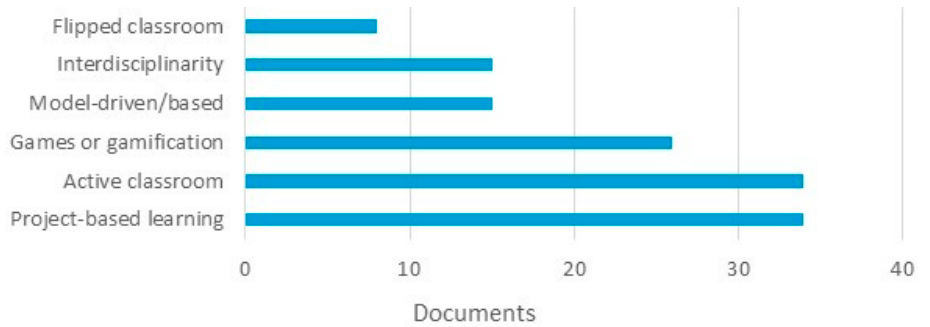
Figure 4. Some strategies for SE education.